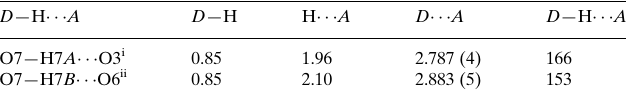
Hydrogen-bond geometry (A˚ , (cid:3)